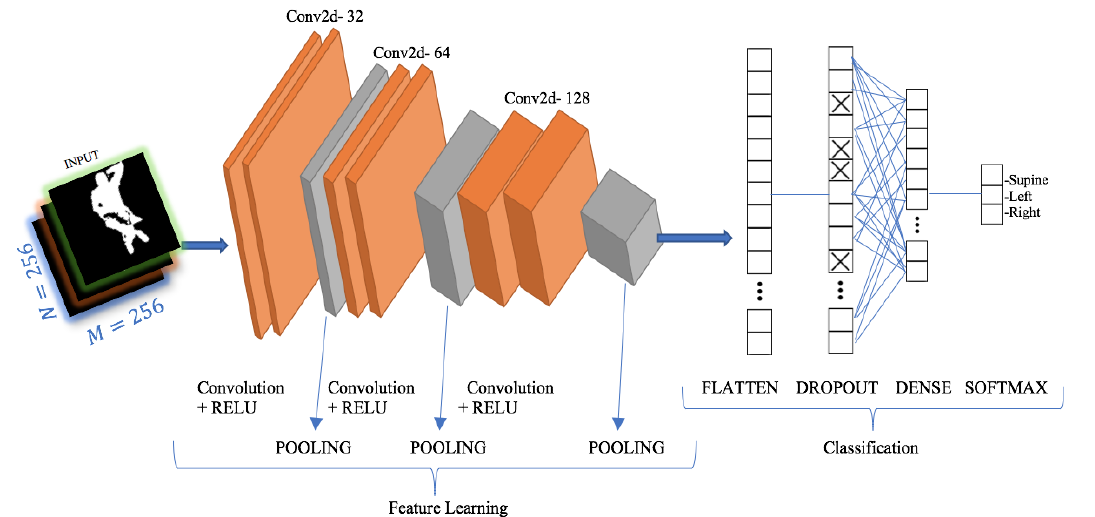
Figure 2. Proposed Model for